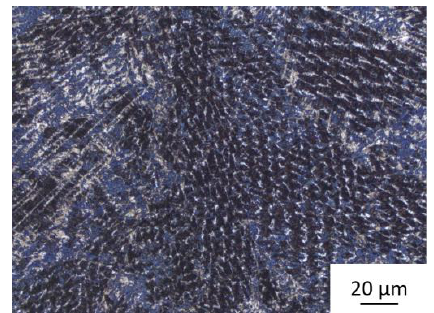
Figure 6. Typical microstructure of the weld metal.